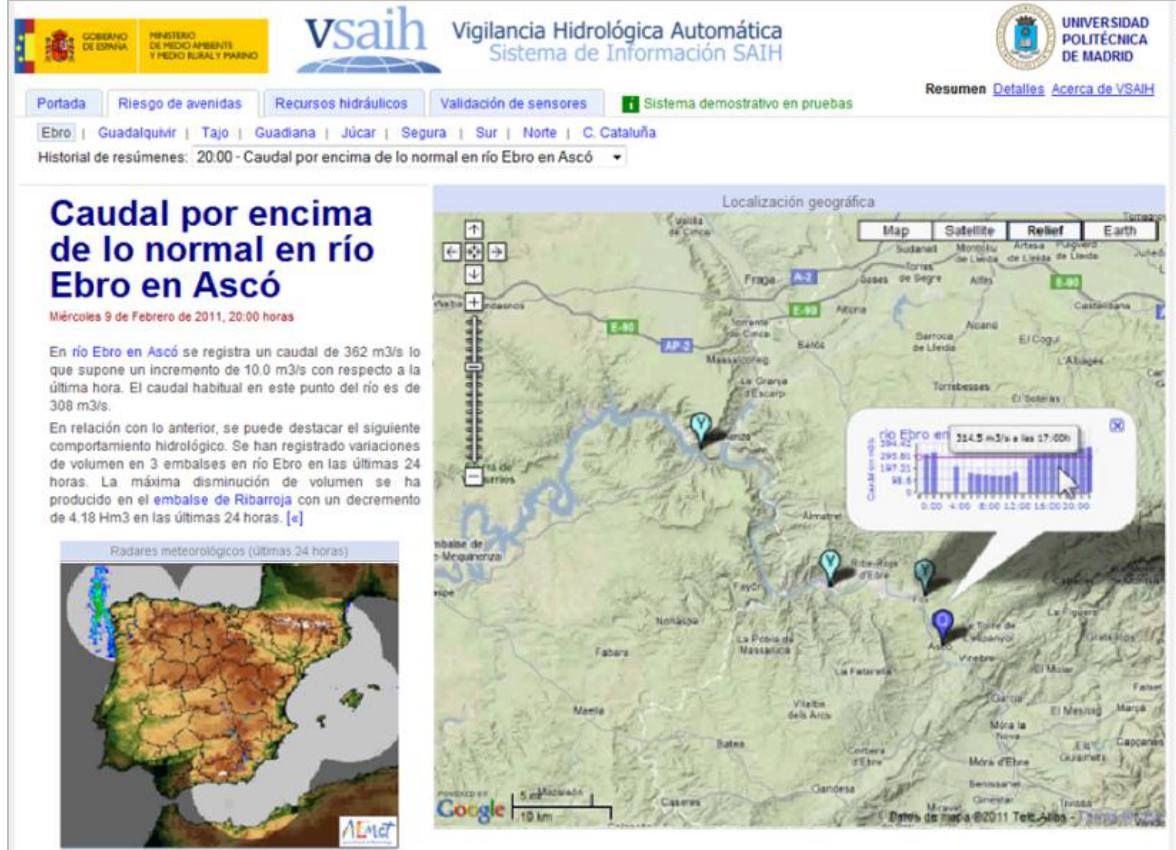
Figure 2. Example of a presentation generated by the VSAIH